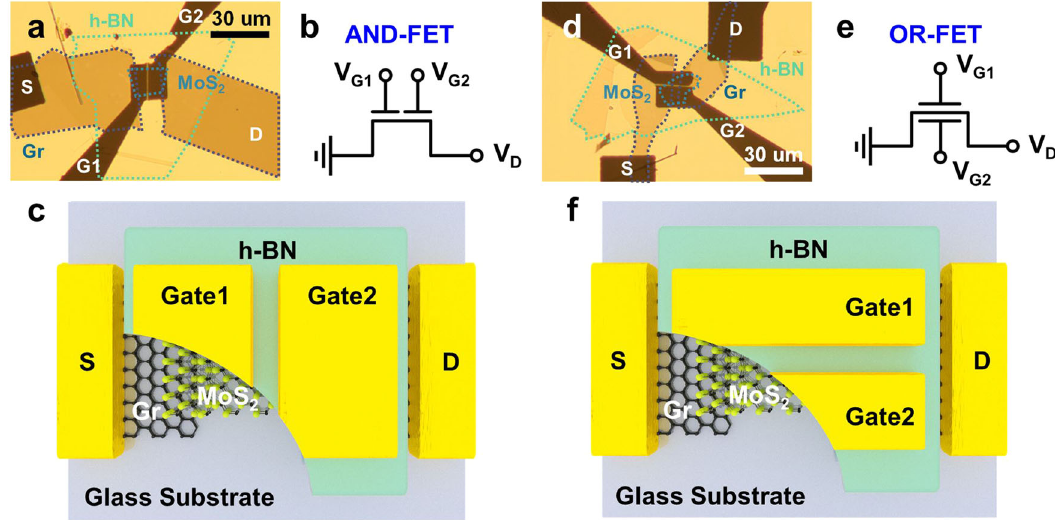
Fig. 1 Longitudinal and latitudinal split-gate models. a , d OM images of the AND-FET ( a ) and the OR-FET ( d ) taken by bottom illumination through a glass substrate. b , e Circuit symbols of the AND-FET ( b ) and the OR-FET ( e ). c , f 3D schematic top view of the AND-FET ( c ) and the OR-FET ( f Methods section and Supplementary Fig. 1. Figure 1b, c show the circuit symbol and 3D schematic top view of the AND-FET.